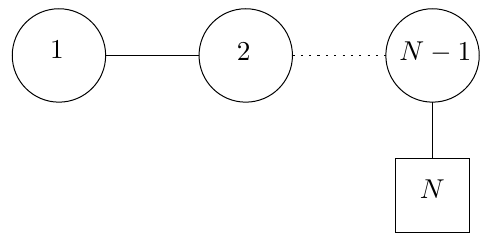
Figure 6. N = 4 Quiver diagram for the T [SU( N )]